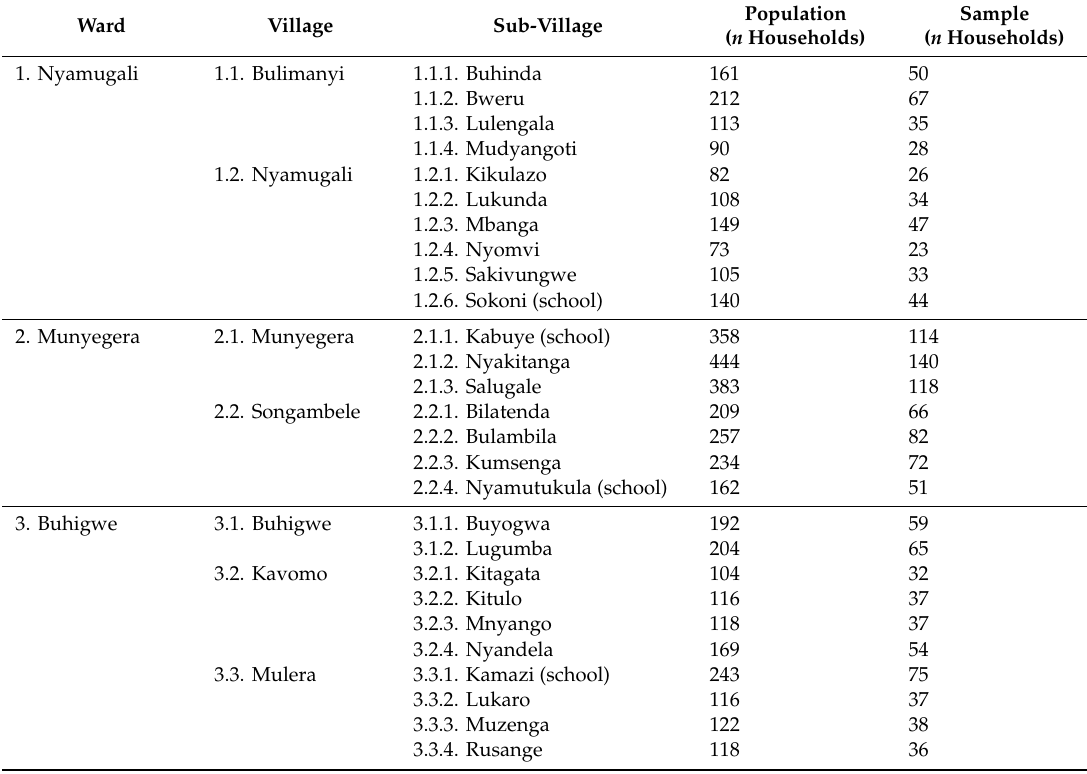
Table 1. Total population and sample in the intervention area. The intervention area consists of 3 wards, including 7 villages and 27 sub-villages. A total population of 4782 households live in the intervention area, of which a sample of 1500 households will be included in the study. Four of the sub-villages had a school. Ward Village Sub-Village